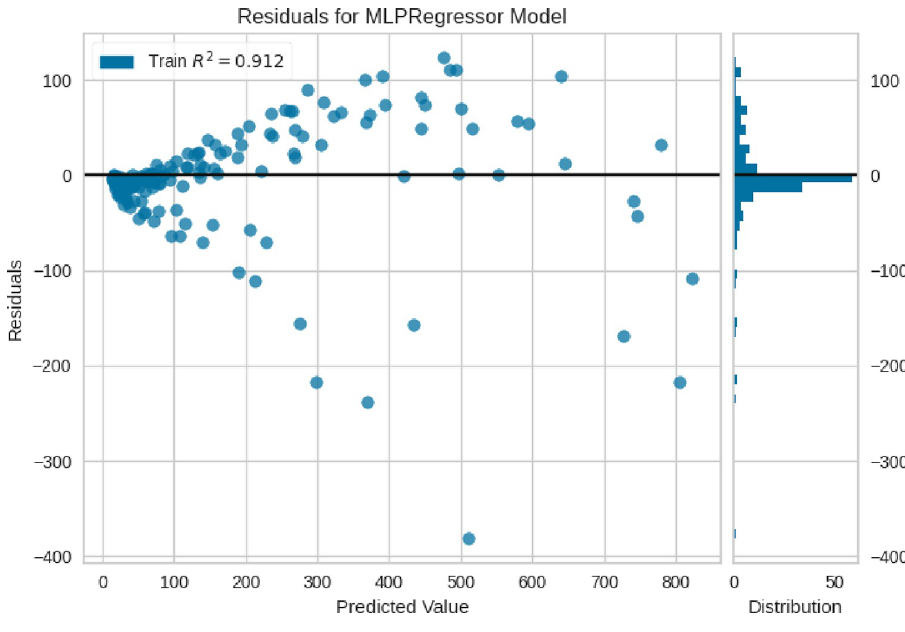
Fig 7. Residual plot of tuned MLP model.